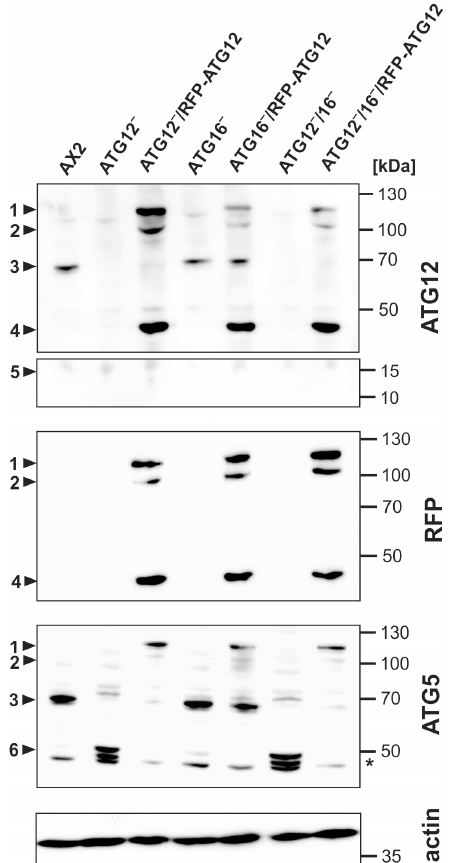
Figure 2. Verification of different mutant strains by immunoblotting of total cell lysates of wild-type AX2, ATG12 − , ATG16 − , and ATG12 − /16 − cells, and of mutant strains that express RFP fused N-terminally to ATG12. The ATG12~ATG5 conjugate was detected at about 68 kDa in AX2, ATG16 − , and ATG16 − /RFP-ATG12 cell lysates, but not in the ATG12 knock-out strains (arrowhead 3). In knock-out strains expressing RFP-ATG12, the RFP and the ATG12 antibodies detected three bands (arrowheads 1, 2, and 4) and the ATG5 antibody detected two bands (arrowheads 1 and 2). No unconjugated ATG12 of about 14 kDa was detected in AX2 and ATG16 − cells (arrowhead 5). Unconjugated ATG5 of about 46 kDa was detected in ATG12 − and ATG12 − /16 − cells (arrowhead 6). Arrowhead legend: 1 = 115 kDa; 2 = 103 kDa, RFP-ATG12~5; 3 = 68 kDa, ATG12~5; 4 = 46 kDa, RFP-ATG12; 5 = 14 kDa, position of unconjugated ATG12; 6 = 46 kDa, unconjugated ATG5. * = degradation product of ATG5. ATG12, RFP, and actin were visualized on the same membrane. ATG5 immunoblots were performed separately. Actin was used as a loading control. Top rows: ATG12 mAb; upper middle row: RFP pAb; lower middle row: ATG5 pAb; bottom row: actin